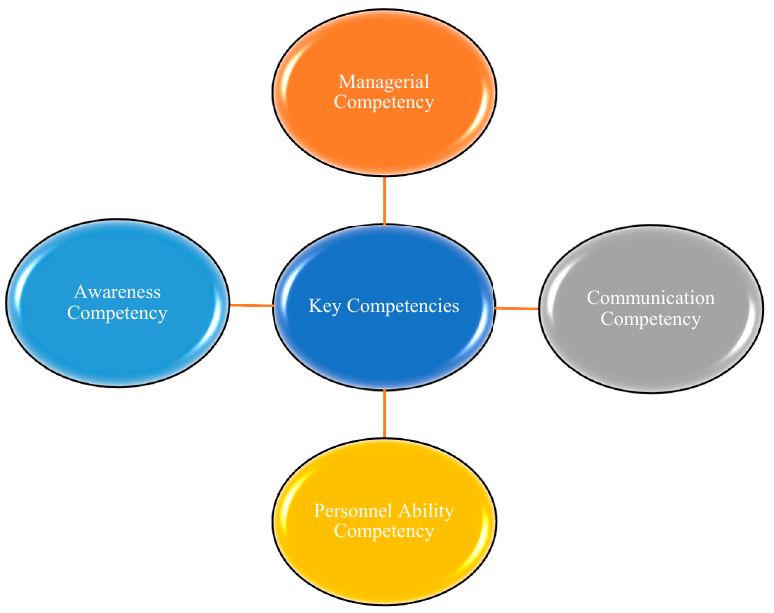
Figure 2. Conceptual Module on Key Competencies that Influence Material Waste Minimization at the Construction Stage of Projects.